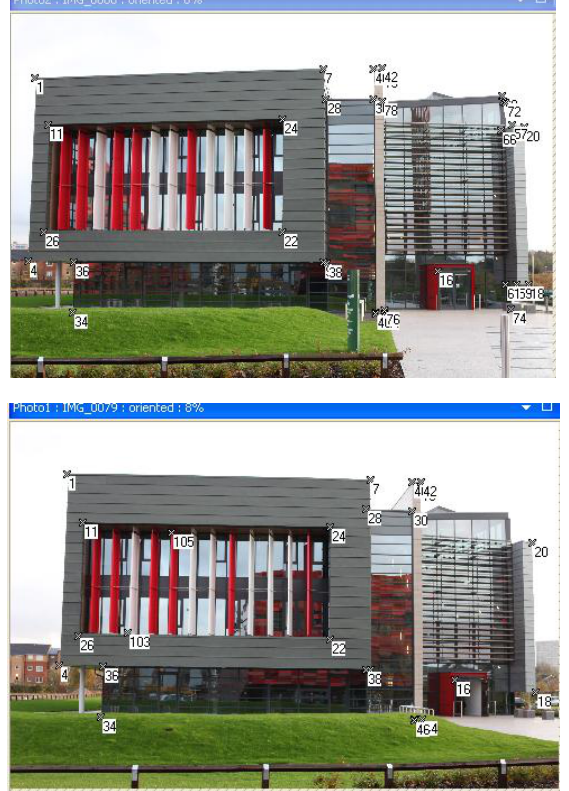
Figure 11. Two overlapping images from Canon EOS 5D Mk II with tie points measured in PhotoModeler